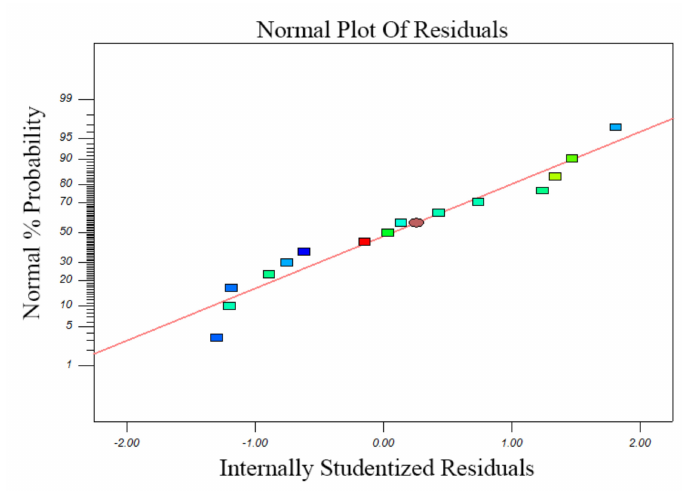
Figure 9. The normal plot of residuals of the build time.